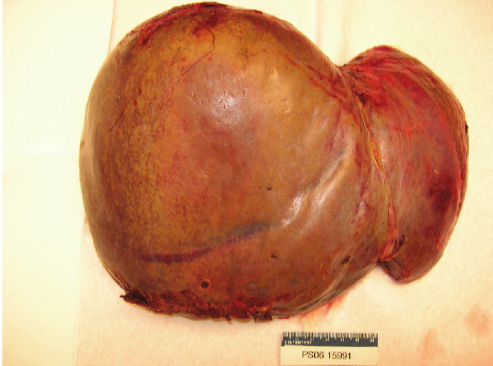
Figure 5: Explant of Allograft: 2531 g liver (expected weight 1500- 1800 g) congested parenchyma with approximately 30% necrosis of the left lobe.